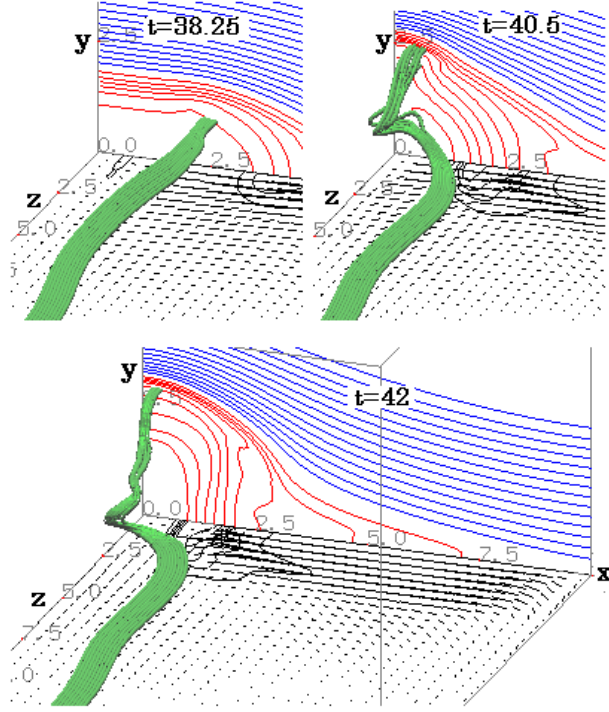
Fig. 7. Current flow lines starting from the segment, 2 . 16 <x< 2 . 72 at y = 0 . 27 and z = 13 for the case of k z = 7 in Eq.